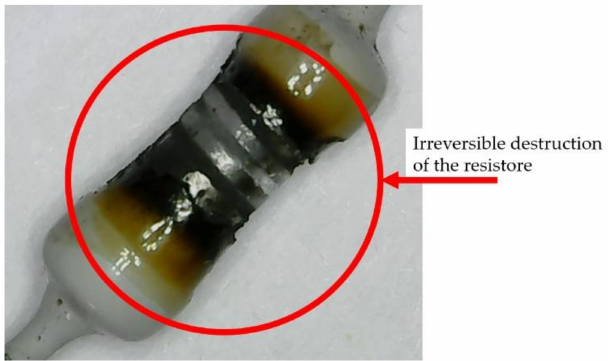
Figure 19. Irreversible destruction of the resistor.